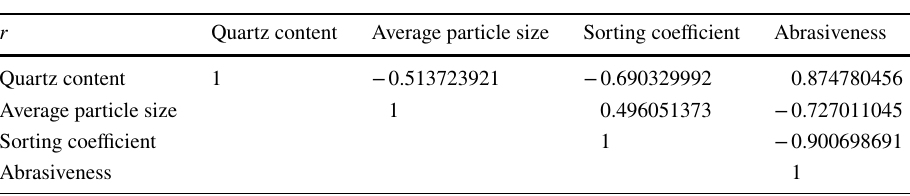
Table 3 The correlation coefficient between the variables